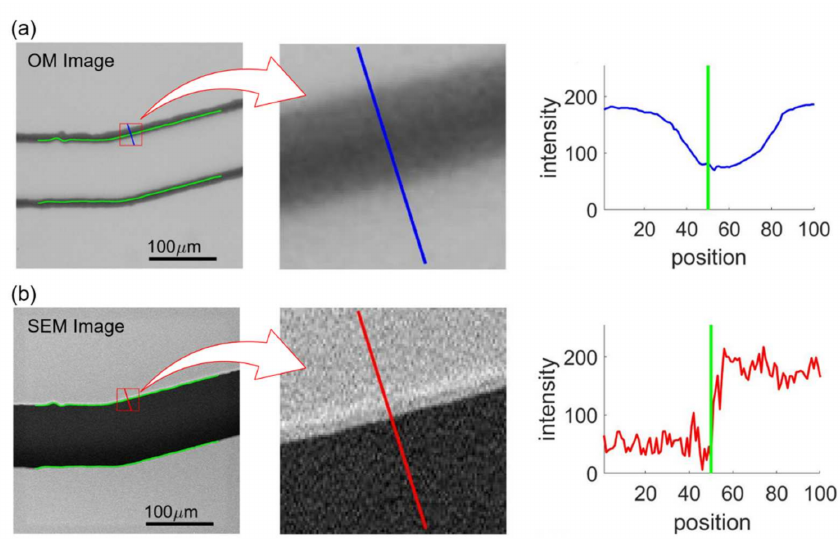
Figure 10. Intensity profiles in OM and SEM image samples. ( a ) OM image. ( b ) SEM